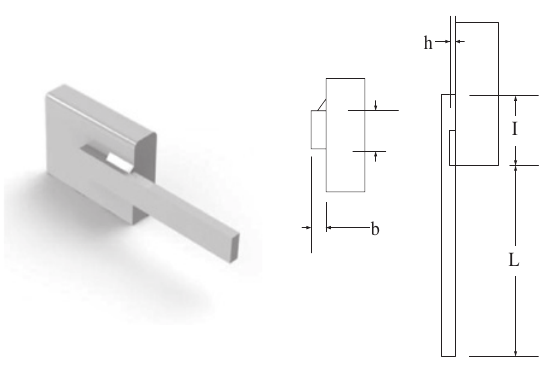
Figure 49: Welded Beam Design Problem.